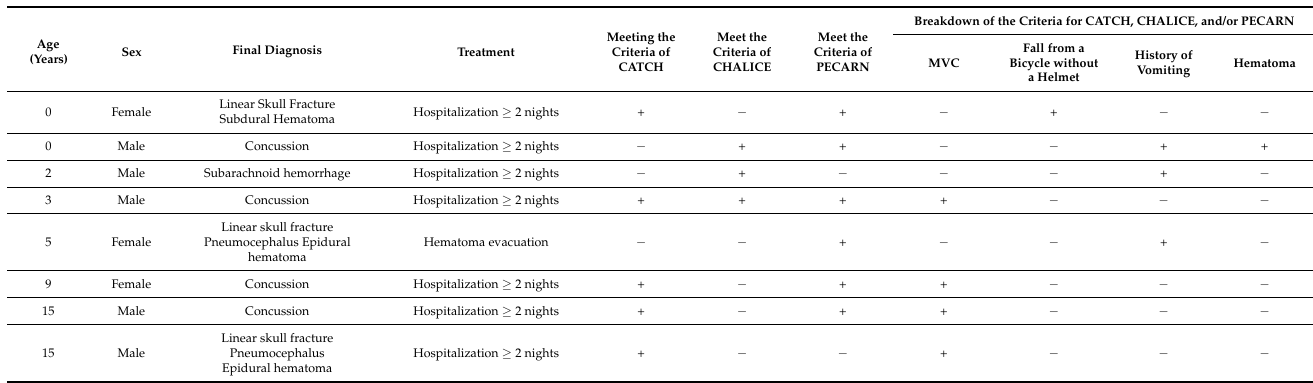
Table 4. Demographic characteristics of patients with ciTBI without simplified CDR predictors.